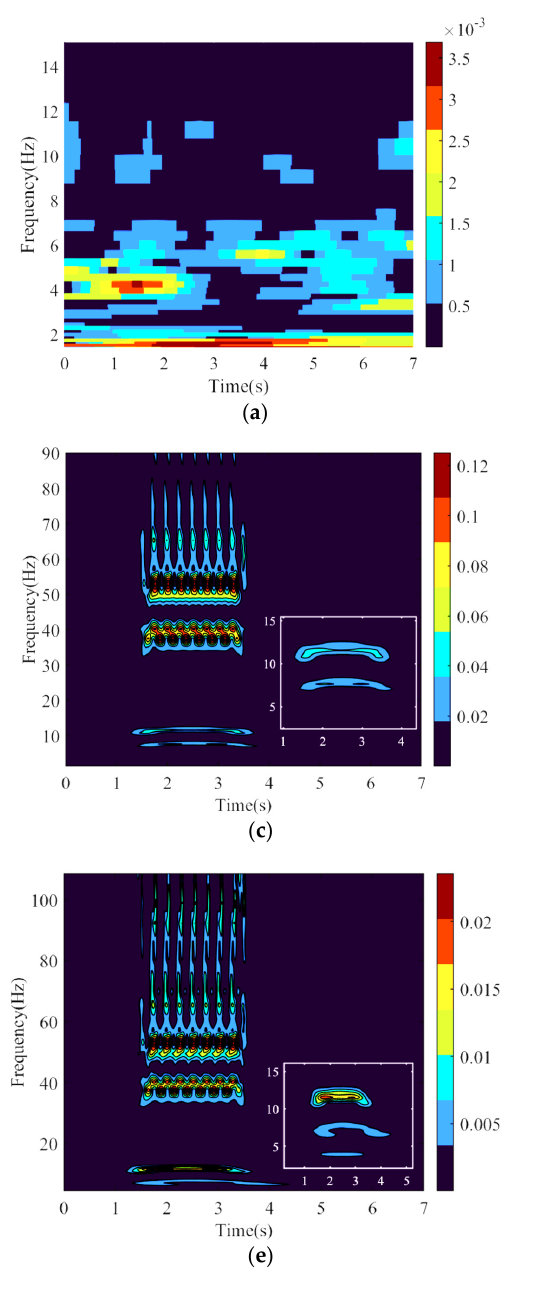
under resonant bridge; ( c ) Mid–rail response scalogram under nonresonant bridge; ( d ) Mid–rail response scalogram under resonant bridge; ( e ) Mid–sleeper response scalogram under